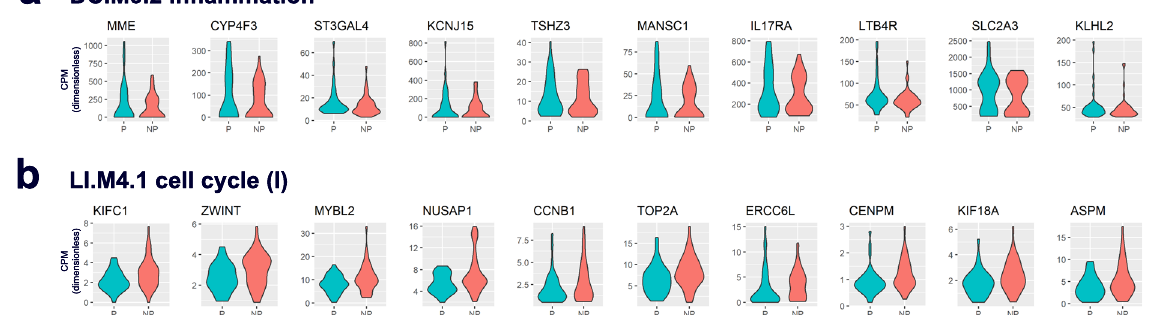
Fig. 2 Violin plots comparing transcript abundance of GSEA-derived leading-edge genes in protected (P) and non-protected (NP) subjects pooled from four malaria vaccine trials. a Transcript abundance in counts per million (CPM) for the top ten leading-edge genes in DC.M3.2 In fl ammation , the gene set showing the highest signi fi cant normalized enrichment score in the GSEA analysis (indicating signi fi cantly higher abundances in protected subjects). b Transcript abundance for the top ten leading-edge genes in LI.M4.1 cell cycle (I) , the gene set showing the lowest signi fi cant normalized enrichment score in the analysis (indicating signi fi cantly lower abundances in protected subjects).